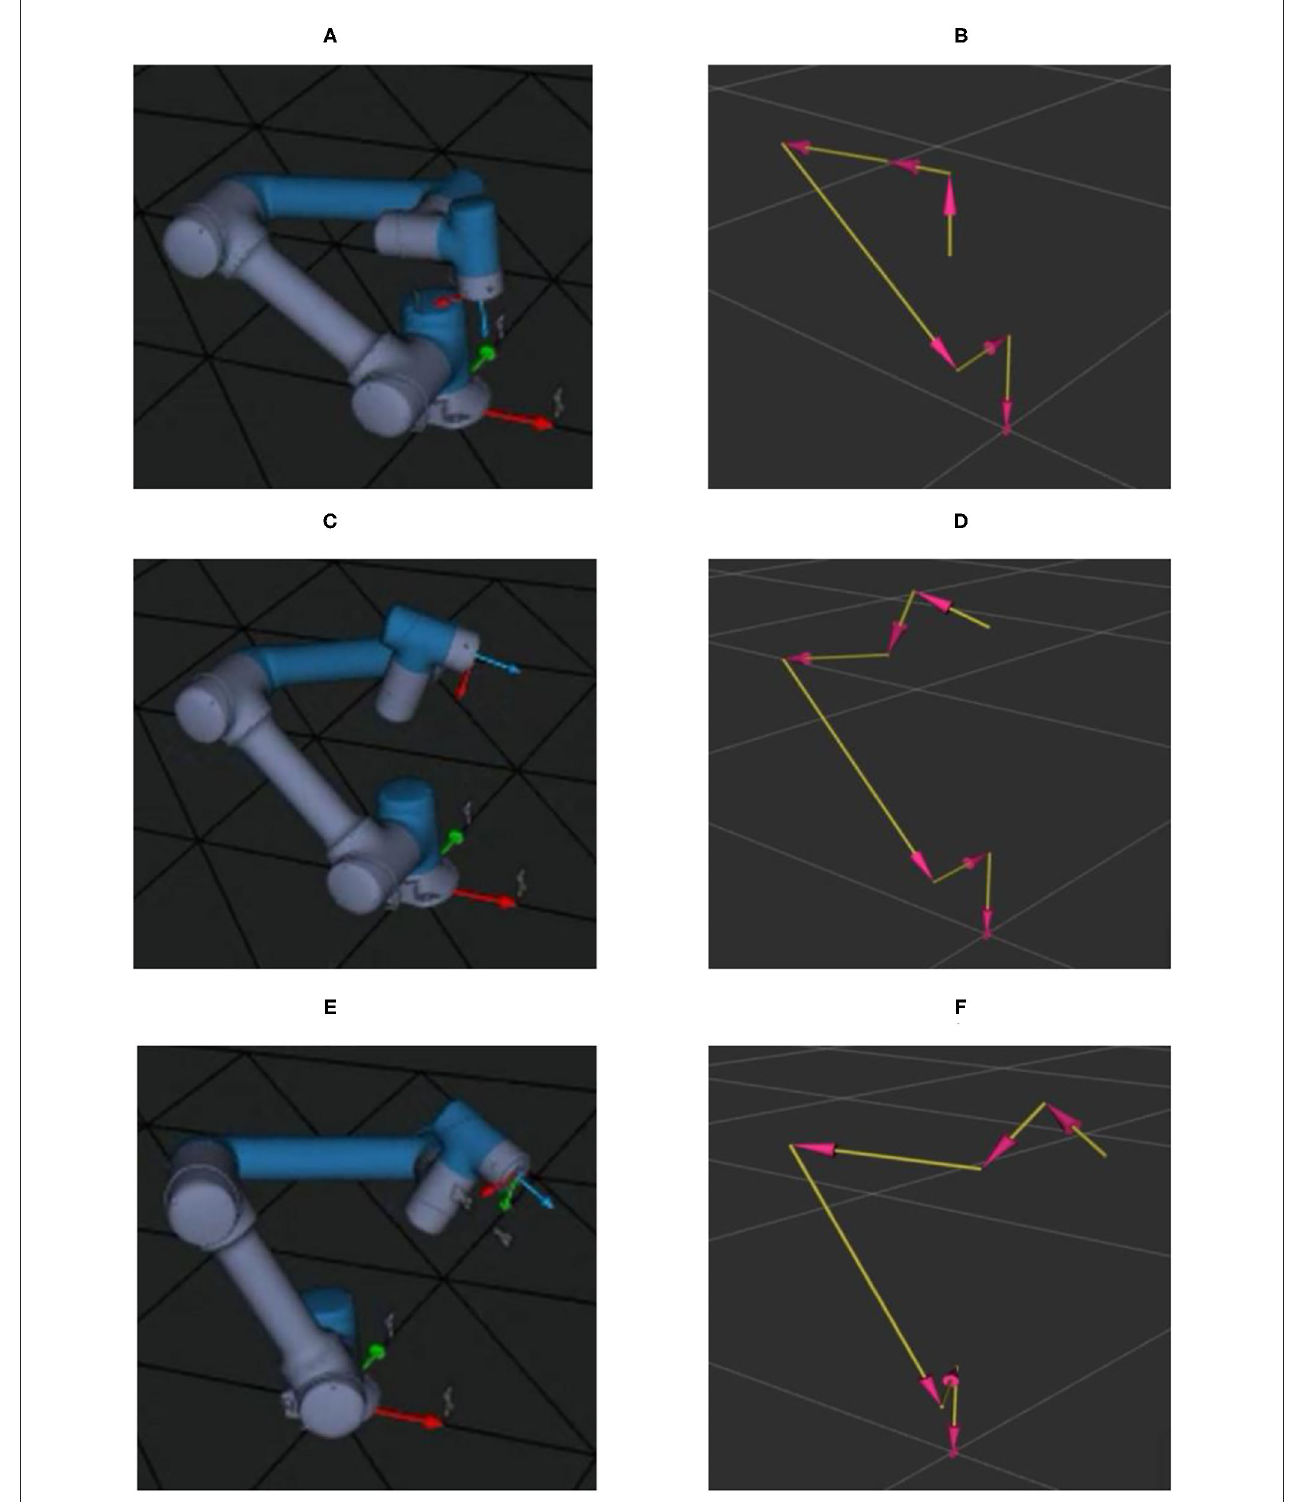
FIGURE 12 | Simulation process of cooperative assembly. (A,B) Represent the initial position. (C,D) Represent robot photo pose. (E,F) Represent collaborative assembly pose.